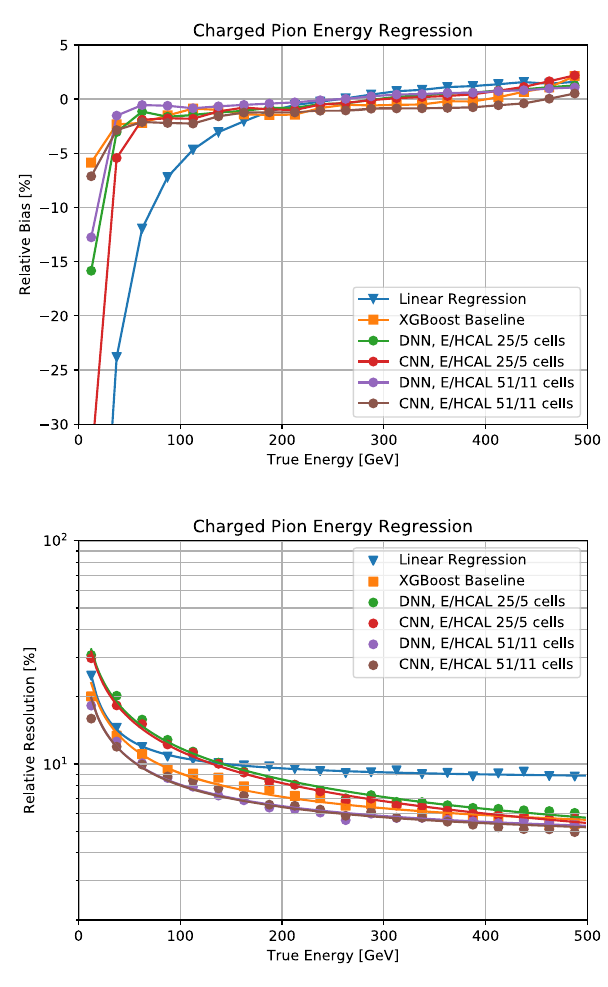
Fig. 41 Bias (top) and resolution (bottom) as a function of true energy for energy predictions for π ± , comparing calorimeter window sizes for the CNN and DNN